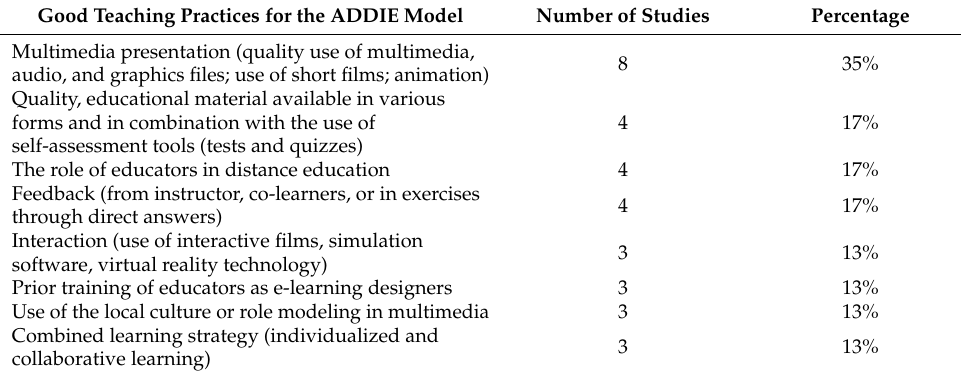
Table 4. Good teaching practices from the application of the model in distance